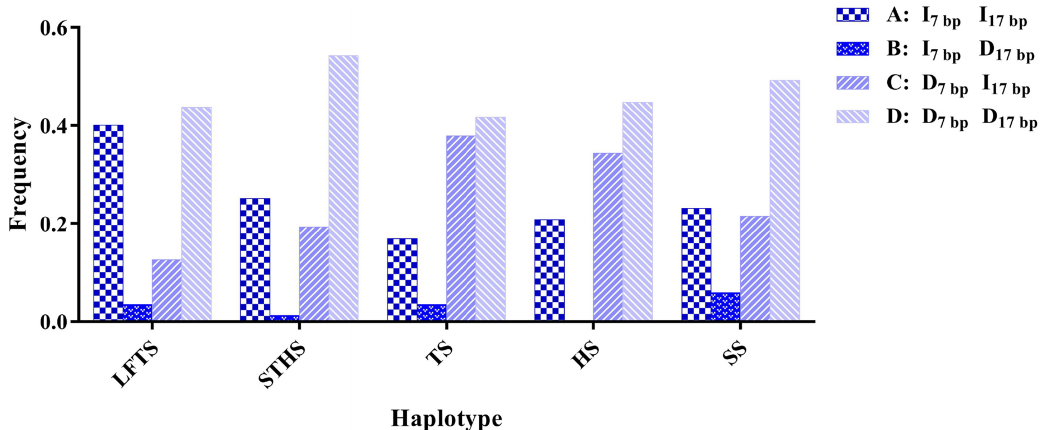
Figure 3. Haplotype frequency of the 5 (cid:48) promoter region-insertion-7bp and 3 (cid:48) UTR-insertion-17bp loci of the ovine SIRT7 gene in different breeds. Note: LFTS – Lanzhou fat-tail sheep; STHS – small-tail Han sheep; TS – Tong sheep; HS – Hu sheep; and SS – Sartuul sheep. Table 4. Association of the novel indel of the ovine SIRT7 gene and growth traits in different breeds (LSM a ± SE). Locus Breeds Sizes Growth traits Observed genotypes (LSM a ± SE) P values II ( n ) ID ( n